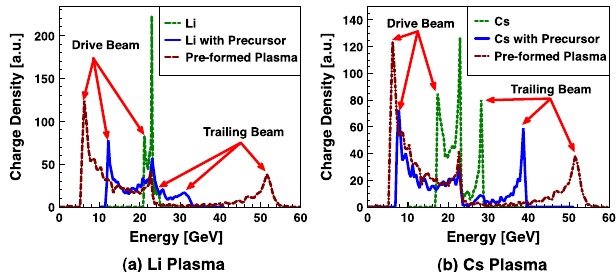
FIG. 9. Energy spectra of the drive beam and the trailing beam at the end of the acceleration: (a) in a field-ionized Li plasma; (b) in a field-ionized Cs plasma.